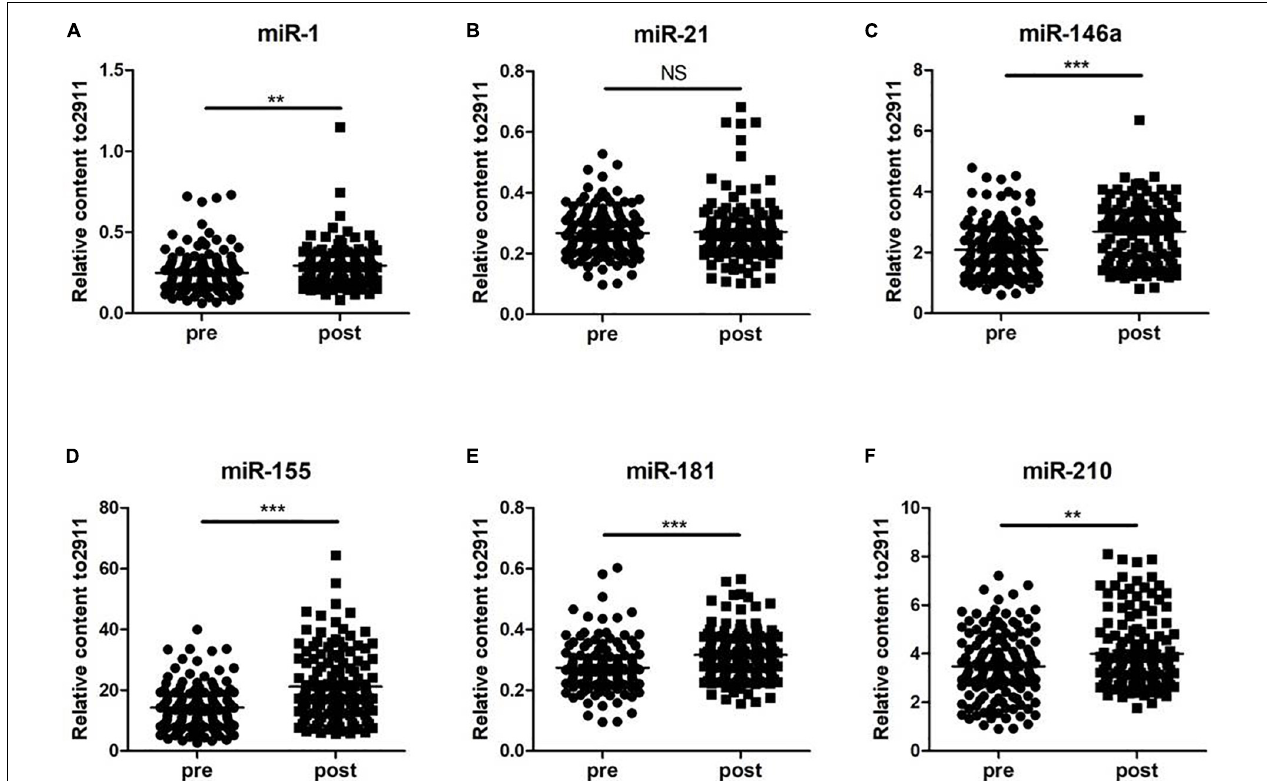
FIGURE 1 | Changes in circulating microRNAs in response to the 5-km run test in 120 young soldiers. The expression levels were evaluated before (pre) and immediately after (post) the 5-km run test. Each point represents the mean of triplicate samples. (A) miR-1; (B) miR-21; (C) miR-146a; (D) miR-155; (E) miR-181; and (F) miR-210. The p -value was derived from the non-parametric Mann–Whitney U test between the pro- and postgroups. ** p < 0.01; *** p <